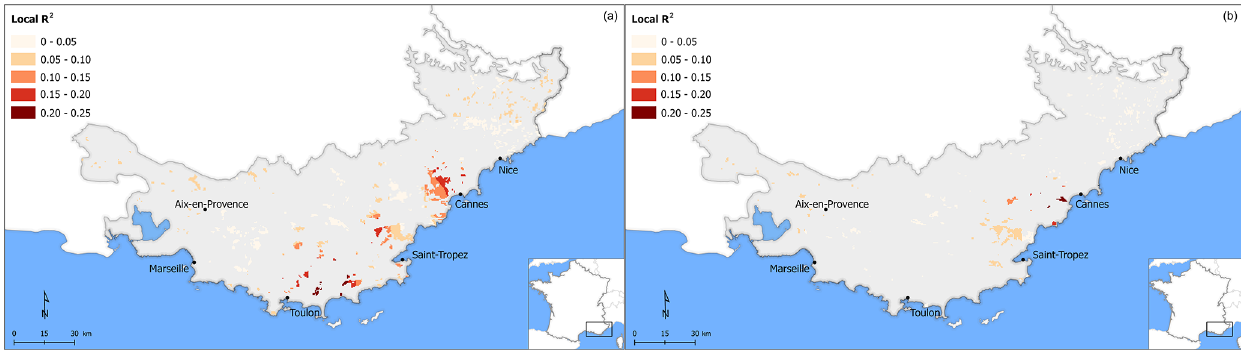
Figure 20. Spatial distribution of local R 2 between the burned area and percent cover of the mixed forest for 1970–1994 (a) and 1995– 2019 (b)